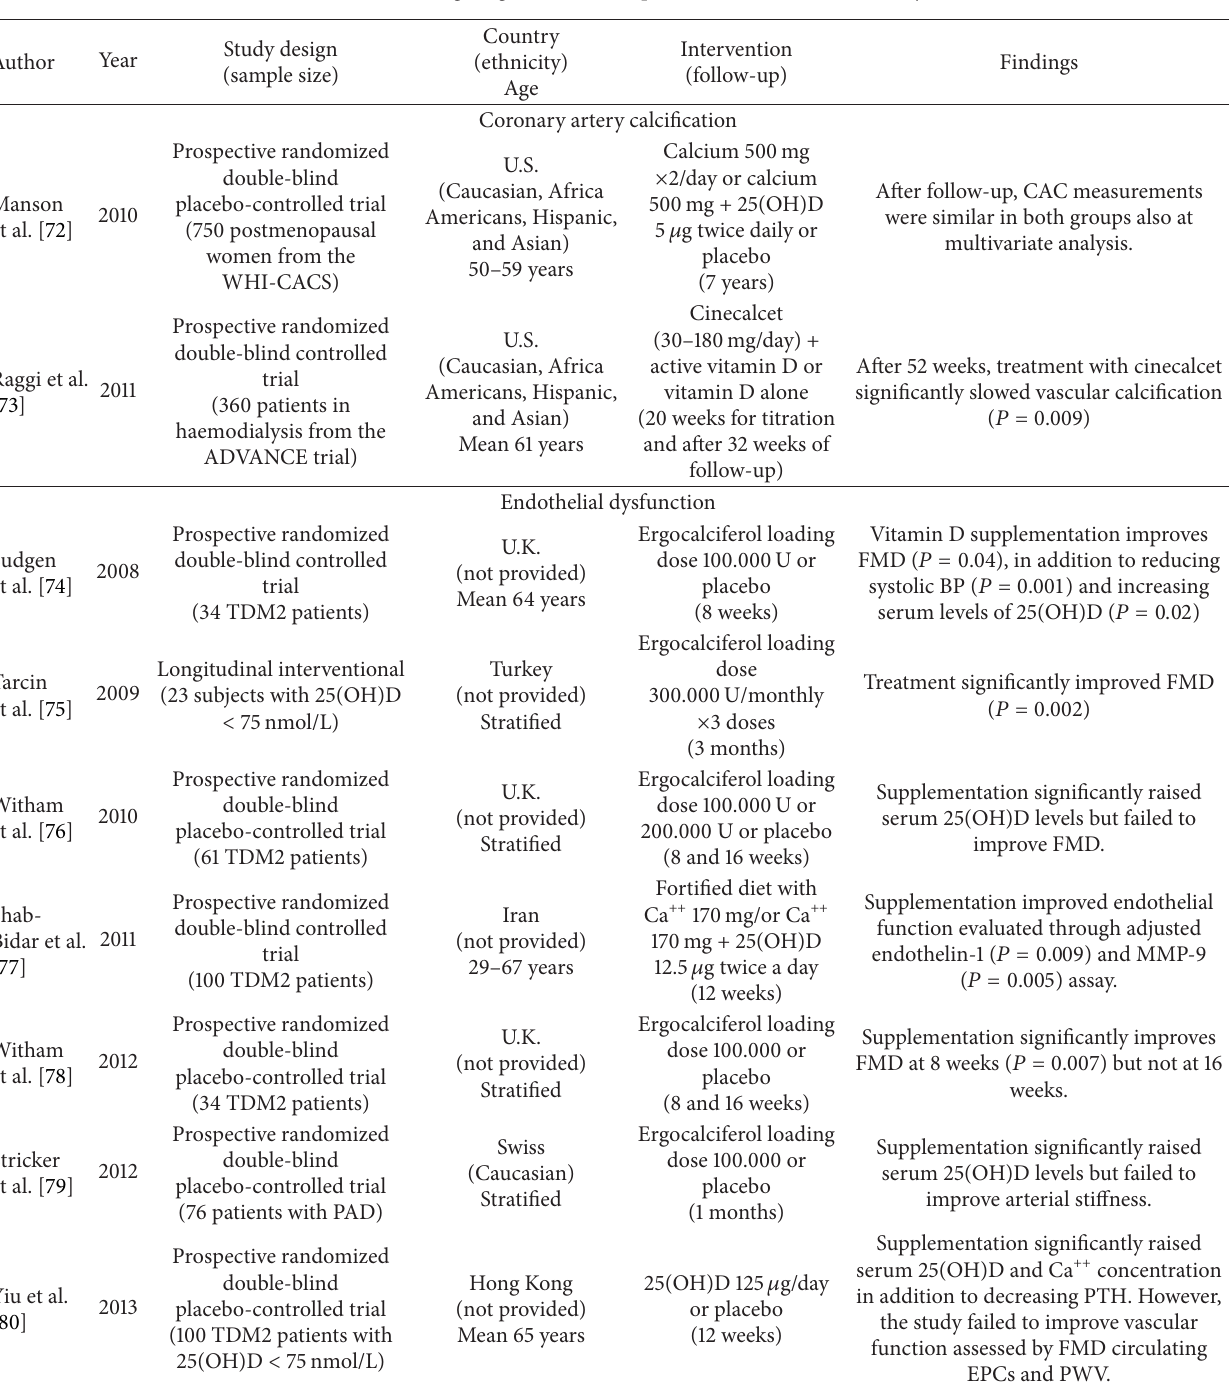
Table 4: Interventional studies investigating the relationship between vitamin D deficiency and atherosclerosis.